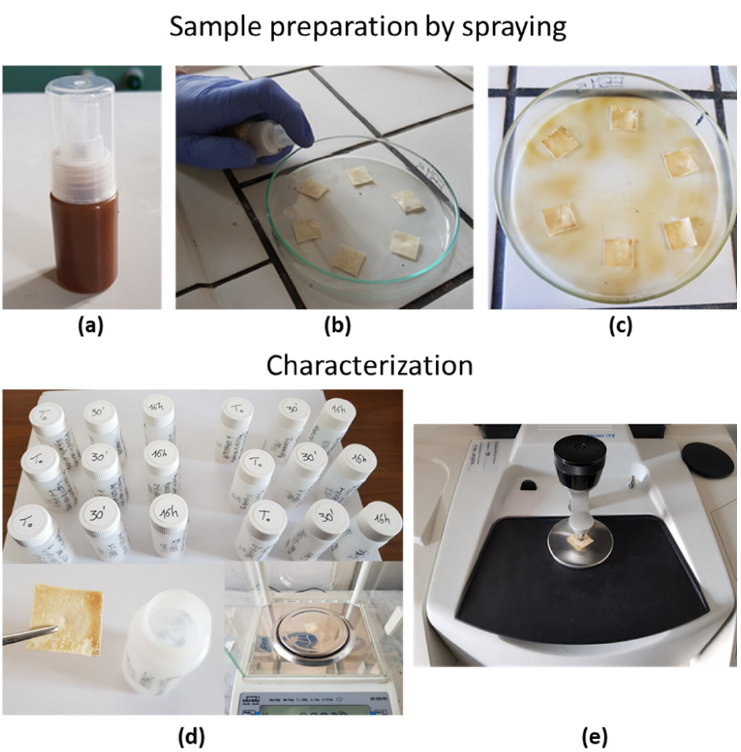
Figure 5. Pictures related to: ( a ) water-based suspension containing CN-LG-Vit-E, ( b ) application of CN-LG-Vit-E onto the films, ( c ) films after the CN-LG-Vit-E application, ( d ) water extraction, drying and weight of samples and ( e ) ATR-infrared analysis of dried films.